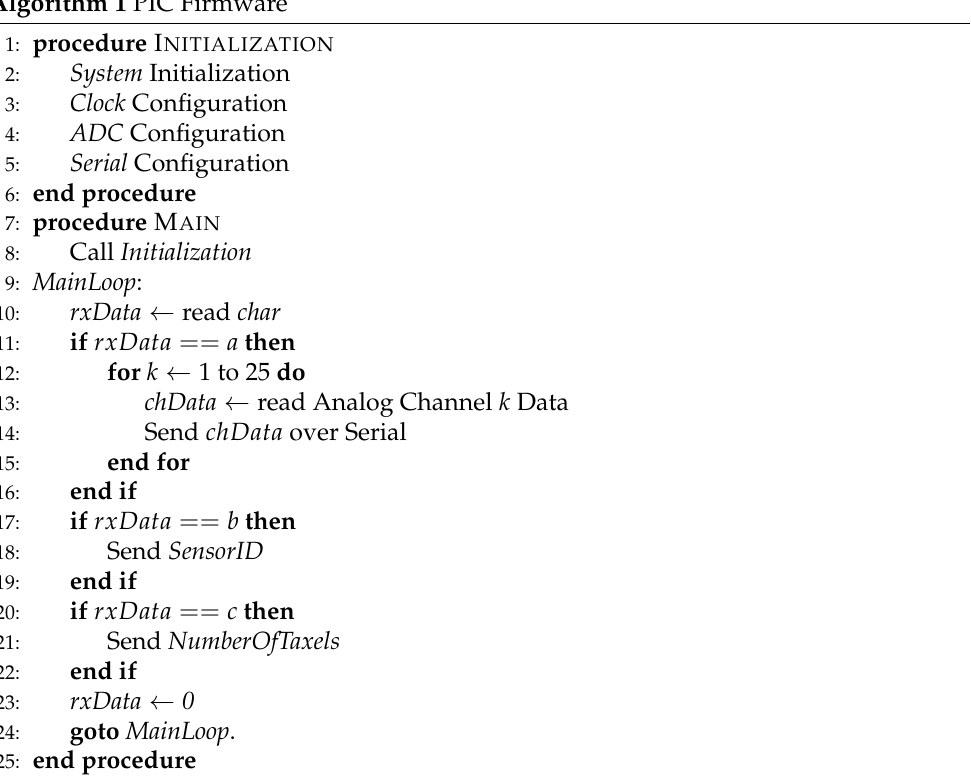
Algorithm 1 PIC